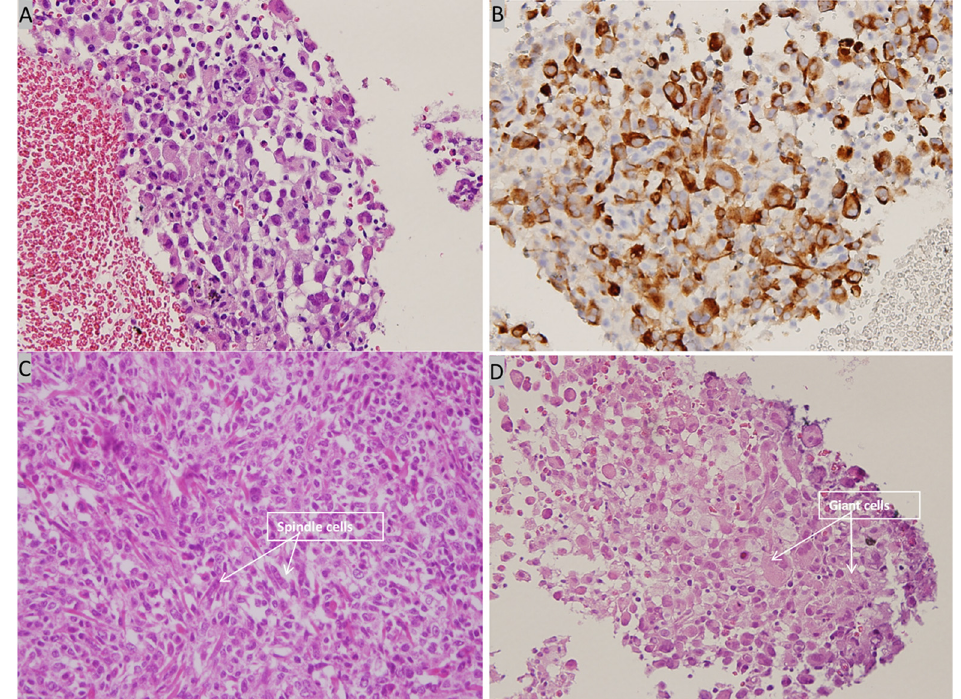
Figure 7. Histopathological examination of bronchoscopic biopsy. ( A ) High power view showing many tumor cells with eccentric nuclei and eosinophilic cytoplasm (H&E, 400×). ( B ) Immunohistochemical staining is positive for cytokeratin (cytokeratin, 400×). ( C ) High power view showing spindle cells with pleomorphic nuclei (H&E, 400×) ( D ) High power view showing giant cells (H&E, 400×).